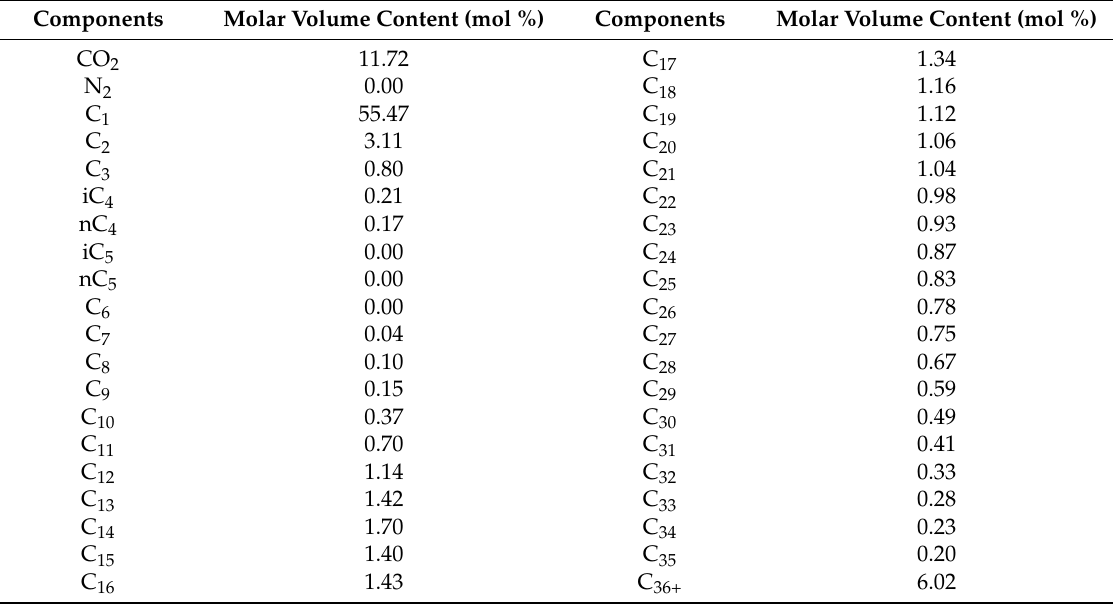
Table 4. Composition of crude oil in a buried-hill